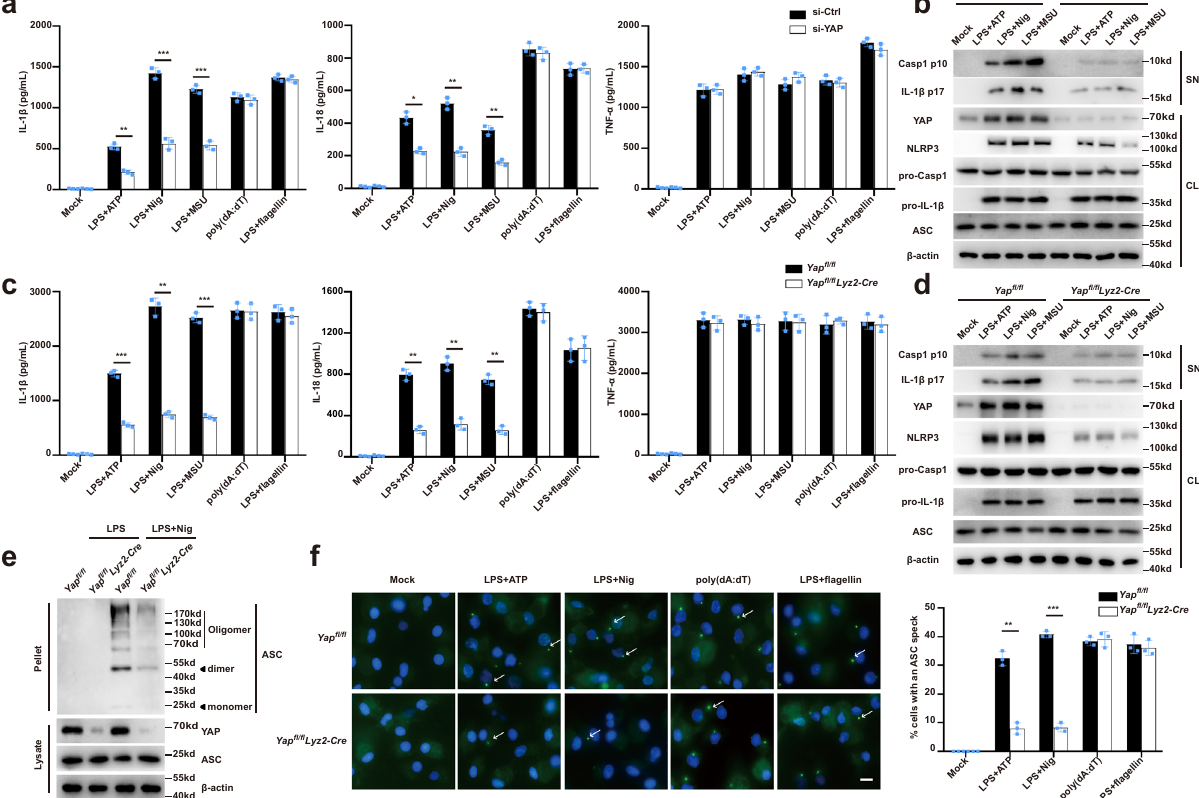
Fig. 1 YAP speci fi cally promotes NLRP3 in fl ammasome activation. a ELISA of IL-1 β , IL-18, and TNF- α in supernatants from mouse peritoneal macrophages silenced of YAP, treated with indicated stimuli (mean ± SD, two-way ANOVA with Bonferroni test, YAP siRNA vs. Ctrl siRNA, left panel: ** P = 0.0023, *** P = 0.0007, *** P = 0.0005 in sequence; middle panel: * P = 0.0222, ** P = 0.0033, ** P = 0.0076 in sequence; n = 3 independent experiments). b Immunoblot analysis of supernatants (SN) or cell lysates (CL) from mouse peritoneal macrophages silenced of YAP, treated with indicated stimuli. c ELISA of IL-1 β , IL-18, and TNF- α in supernatants of mouse peritoneal macrophages from Yap fl / fl lyz2-Cre or Yap fl / fl mice, then treated with indicated stimuli (mean ± SD, two-way ANOVA with Bonferroni test, Yap fl / fl lyz2-Cre vs. Yap fl / fl , left panel: *** P = 0.0003, ** P = 0.0046, *** P = 0.0006 in sequence; middle panel: ** P = 0.0021, ** P = 0.002, ** P = 0.0013 in sequence; n = 3 independent experiments). d Immunoblot analysis of supernatants (SN) or cell lysates (CL) of mouse peritoneal macrophages from Yap fl / fl lyz2-Cre or Yap fl / fl mice, then treated with indicated stimuli. e Immunoblot analysis of ASC oligomerization in cross-linked cytosolic pellets of mouse peritoneal macrophages from Yap fl / fl lyz2-Cre or Yap fl / fl mice, primed with LPS, and followed by stimulation with nigericin. f Representative images of ASC specks in LPS primed Yap fl / fl lyz2-Cre or Yap fl / fl peritoneal macrophages treated with indicated stimuli. ASC, green; nuclei, blue. White arrows indicate ASC specks. Scale bars, 10 μ m (left). The percentage of cells containing an ASC speck was quanti fi ed (right). At least 100 peritoneal macrophages from each genotype were analyzed (mean ± SD, two-way ANOVA with Bonferroni test, Yap fl / fl lyz2- Cre vs. Yap fl / fl , right panel: ** P = 0.0011, *** P < 0.0001 in sequence; n = 3 independent experiments). Similar results were obtained from three